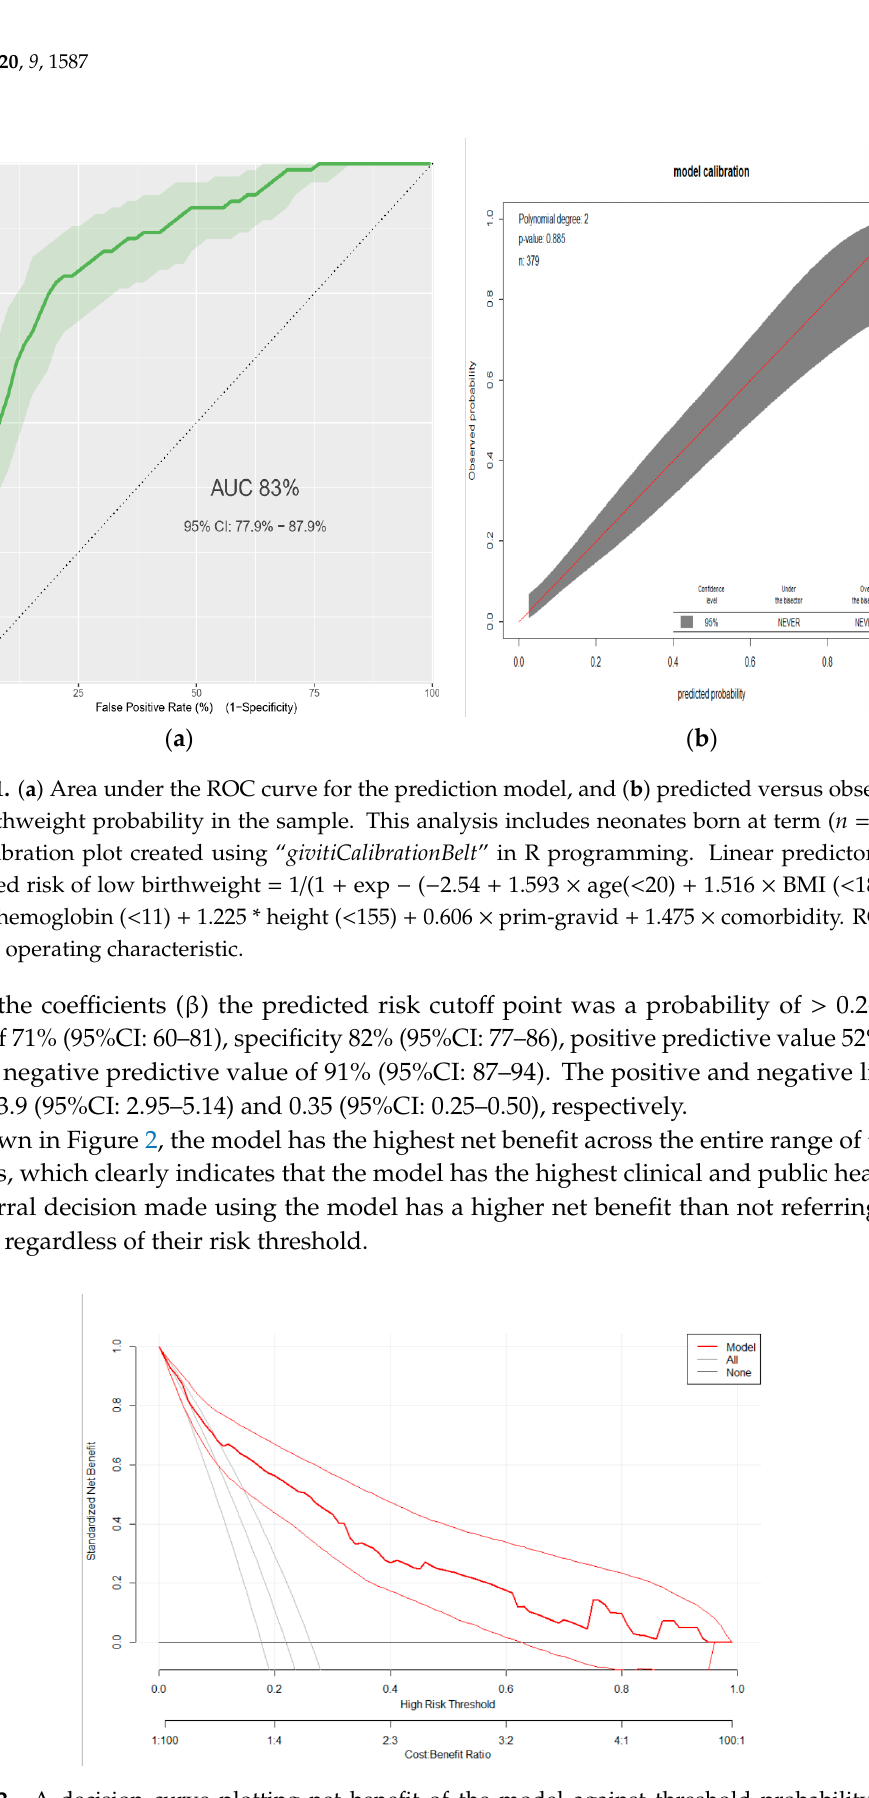
Figure 2. A decision curve plotting net benefit of the model against threshold probability and corresponding cost-benefit ratio.